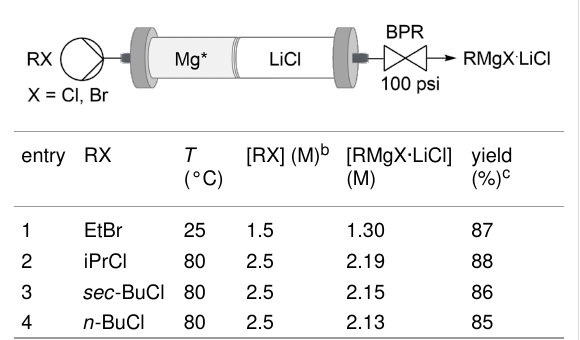
Table 2: Reaction of organic halides with a stratified packed-bed column of activated magnesium and lithium chloride. Scope of turbo Grignard reagents prepared under flow conditions.